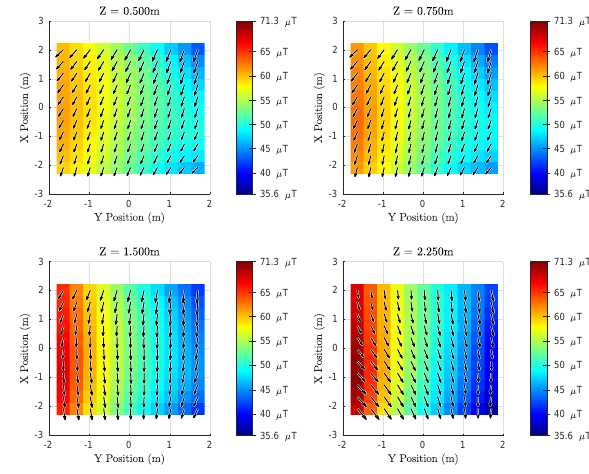
( a ) M-Air magnetic field. North is in the + X direction. ( b ) Fly Lab magnetic field when trained on test_100 (Scan- α ). North is approximately in the − Y direction. Figure 8. Outdoor ( a ) and indoor ( b ) magnetic field at four different altitudes. Black arrows show the direction of the planar ( X − Y ) component of the magnetic field. The color behind each arrow shows the strength and direction of the Z component of the magnetic